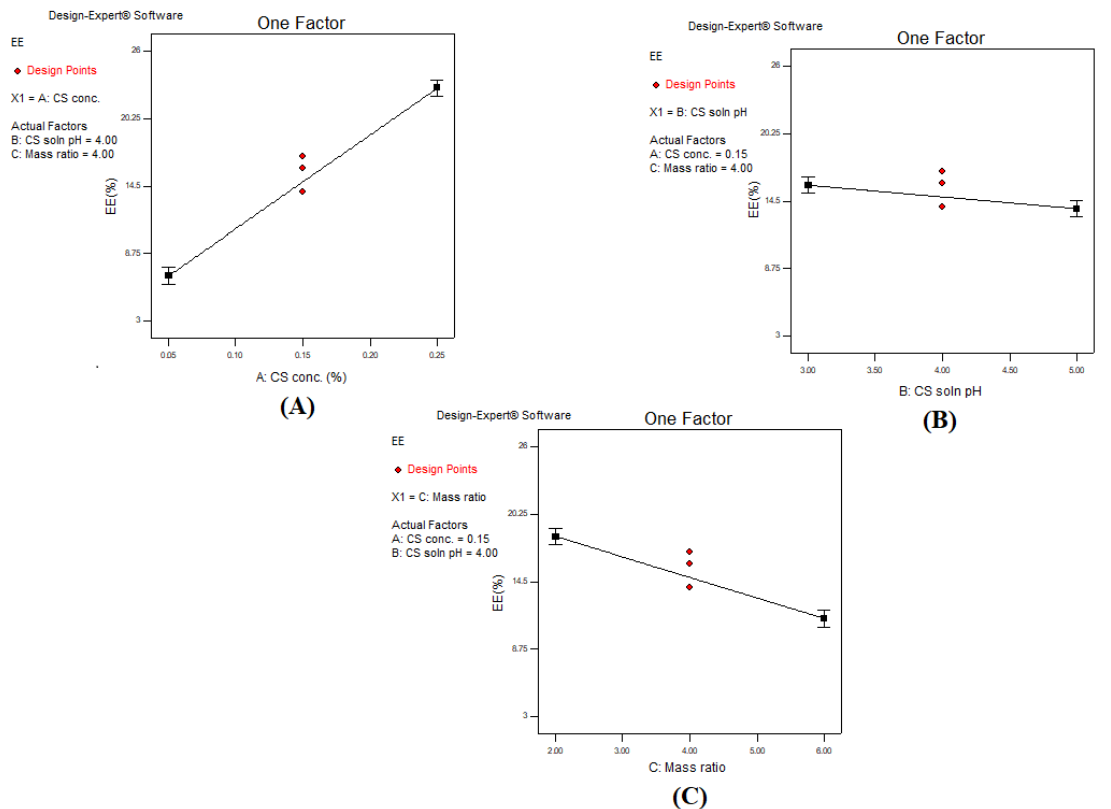
Figure 1. One factor line plot of the main effect of ( A ) chitosan (CS) concentration, ( B ) CS solution pH, and ( C ) chitosan: sodium tripolyphosphate (CS: TPP) mass ratio on EE%.